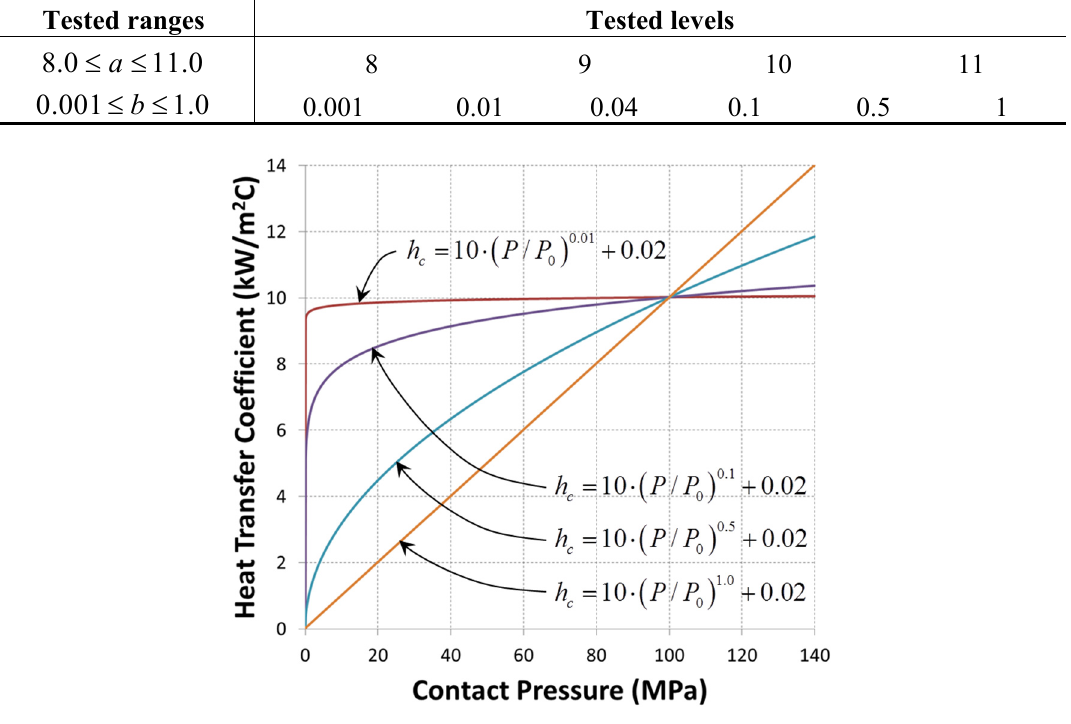
Figure 5. The shape of the power law function expressed by Equation